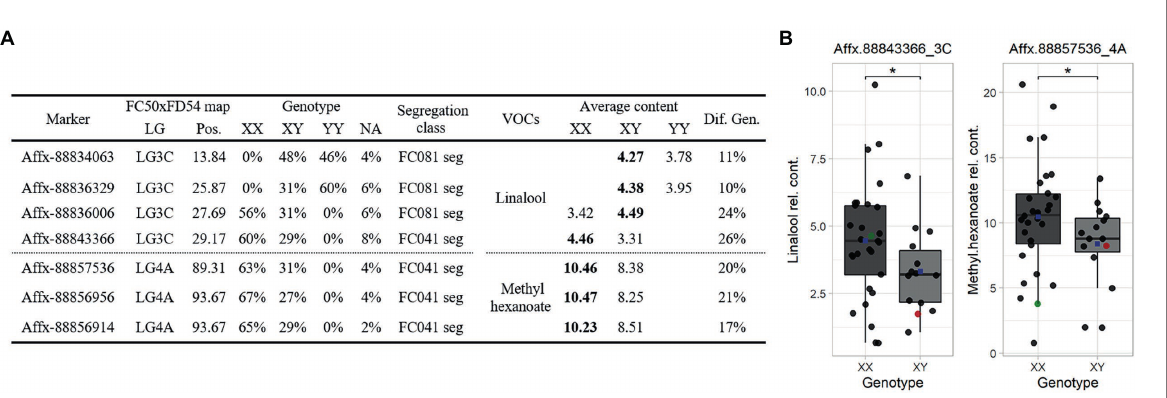
FIGURE 5 (A) Marker linked summary for the Terpene_3C and Hexanoate_4A QTLs in the “C19” population. Bold numbers indicate the genotype linked to the compound accumulation. (B) Linalool (left) and methyl hexanoate (right) boxplot for the “C19” population. Dot colors: progenies (black), “FC041” (red) and “FC081” (green). Blue squares represent means. Significant level < 0.1